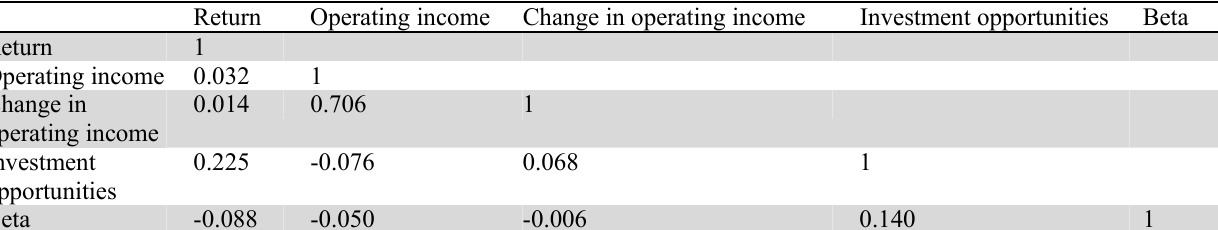
Correlation between variables